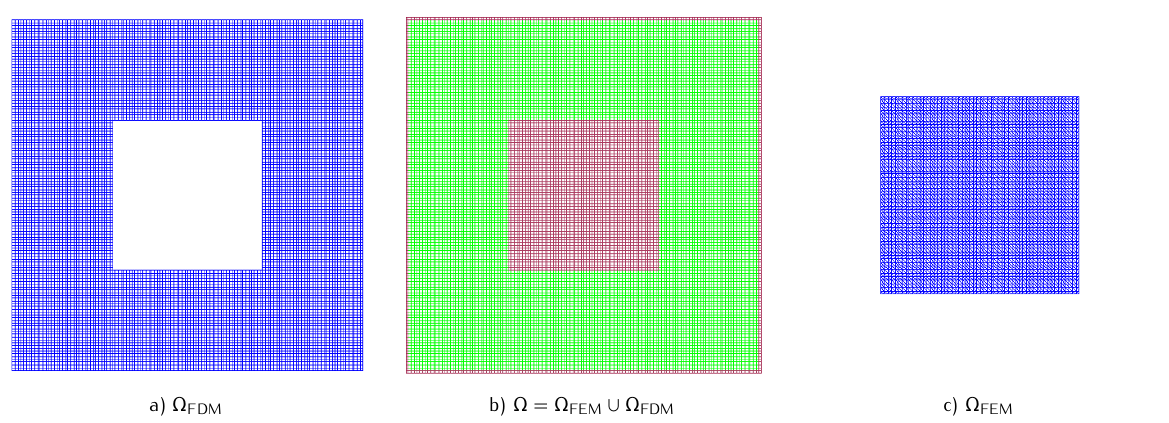
Figure 2. The hybrid mesh b) is a combination of a structured mesh a) , where FDM is applied, and a mesh c) , where we use FEM, with two layers of overlapping structured elements. The coefficient ε ( x ) in (31) is given as follows: ε ( x ) = 1 in Ω